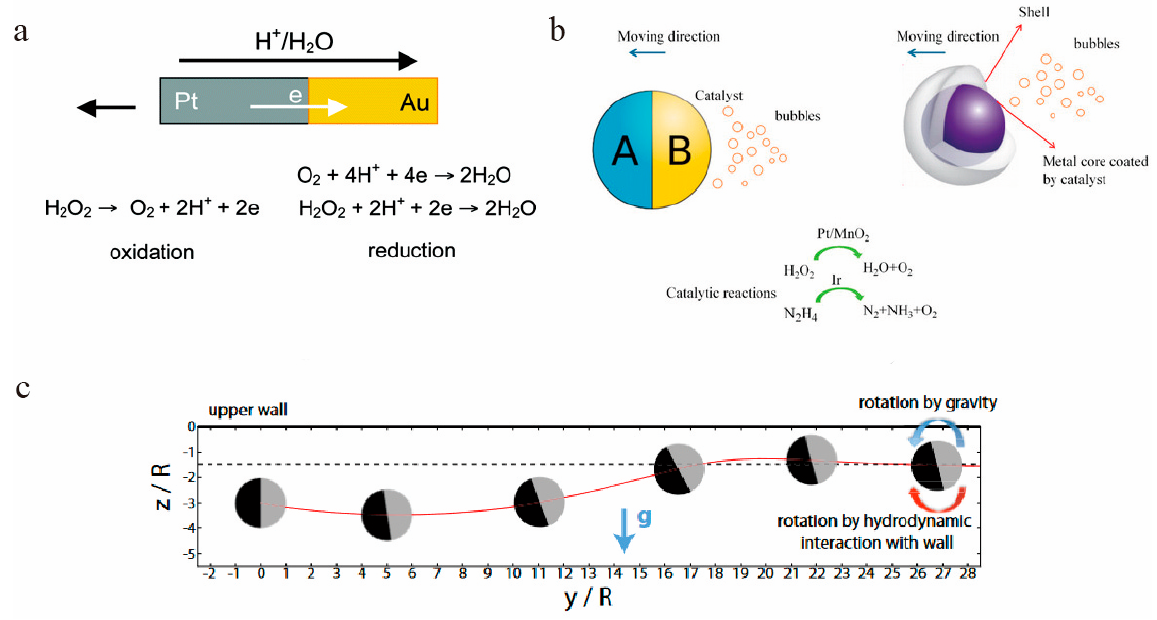
Figure 1. ( a ) Self-electrophoresis drive mode. The anode and cathode of the Au/Pt undergo REDOX reaction (Oxidation and reduction reactions) in H 2 O 2 and generate electric field to drive the movement. The figure has been reproduced with permission from the American Chemical Society [52–54]. ( b ) A Janus Micromotor has a chemical reaction to produce small bubbles of oxygen, which are propelled by the force of bubble recoil. The figure has been reproduced with permission from MDPI [56,57]. ( c ) Schematic diagram of the movement process of self-diffusing swimming particles. The figure has been reproduced with permission from Springer Nature [64].